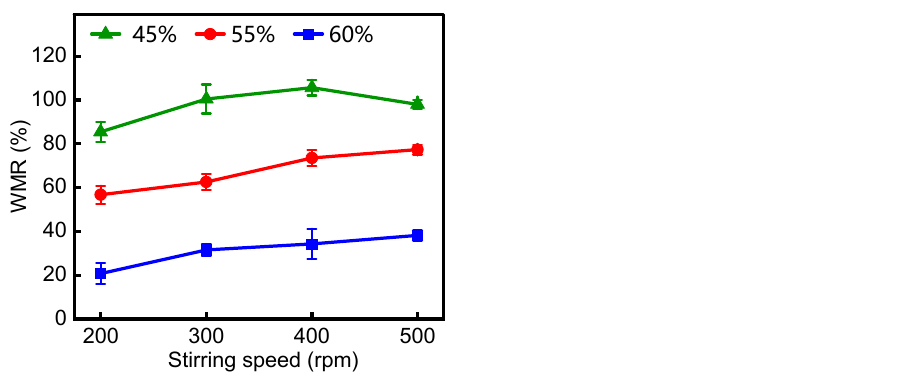
Figure 7. WMR values at different stirring speeds (200, 300, 400 and 500 rpm) and different total solid content of the concentrate (45%, 55%, and 60%) on stirring devices. The results are expressed as mean ± standard deviations, n = 3.